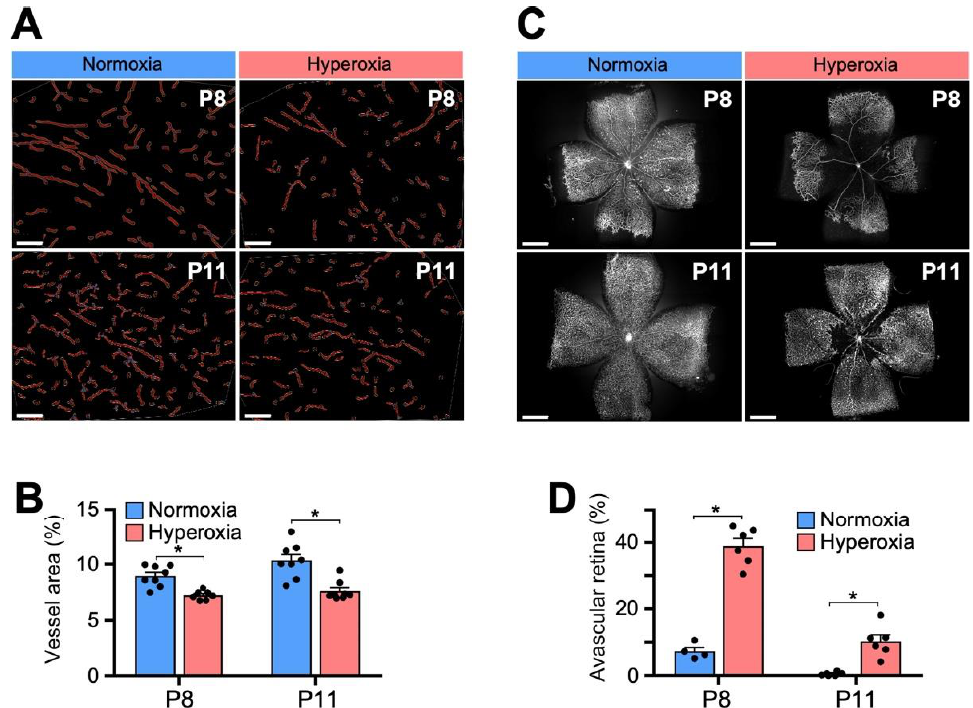
Figure 2. Hyperoxia decreases capillary network in the brain and retina. ( A ) Vasculature segmentation with AngioTool of representative fluorescent images (10×) of lectin immunohistochemical staining of brain capillary networks supplying the external capsule at P8 and P11 in normoxia versus hyperoxia. Scale bar = 100 μ m. ( B ) Brain capillary networks supplying the EC were quantified as mean vessel area in each image. There was decreased vessel area following hyperoxia at both P8 and P11. ( C ) Representative images of lectin-stained retina flat mounts at P8 and P11 after 80% oxygen exposure from P4 – P8. Each image was obtained by merging 16 overlapping fluorescent images. Scale bar = 200 μ m. ( D ) Quantification of retinal flat mounts depicting fraction avascular area of total retinal area. There was increased avascular fraction area at P8 and P11 following hyperoxia. Data shown as mean ± SEM for each group. For each group and time point, 5 images/animal were averaged for 5 – 8 animals. An unpaired two-tailed t test comparing normoxia vs. hyperoxia, where * p < 0.05, was used for statistical analysis.